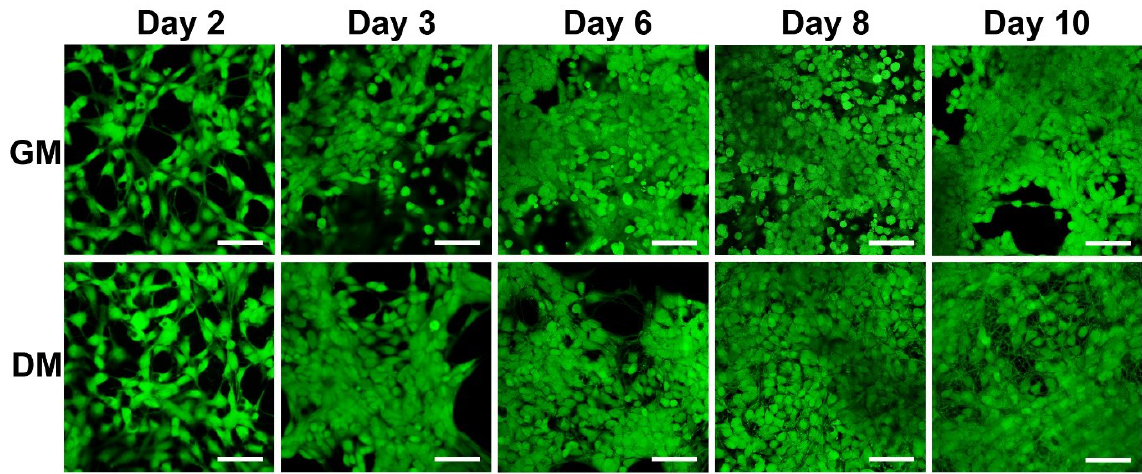
Figure 5. Fluorescence microscopy images of live stained (Calcein AM) hVM1 Bcl-X L cells in growth medium (GM) and differentiation medium (DM). Initial cell density 120,000 cells/cm 2 . Time in days after cell seeding. (Scale bars: 50